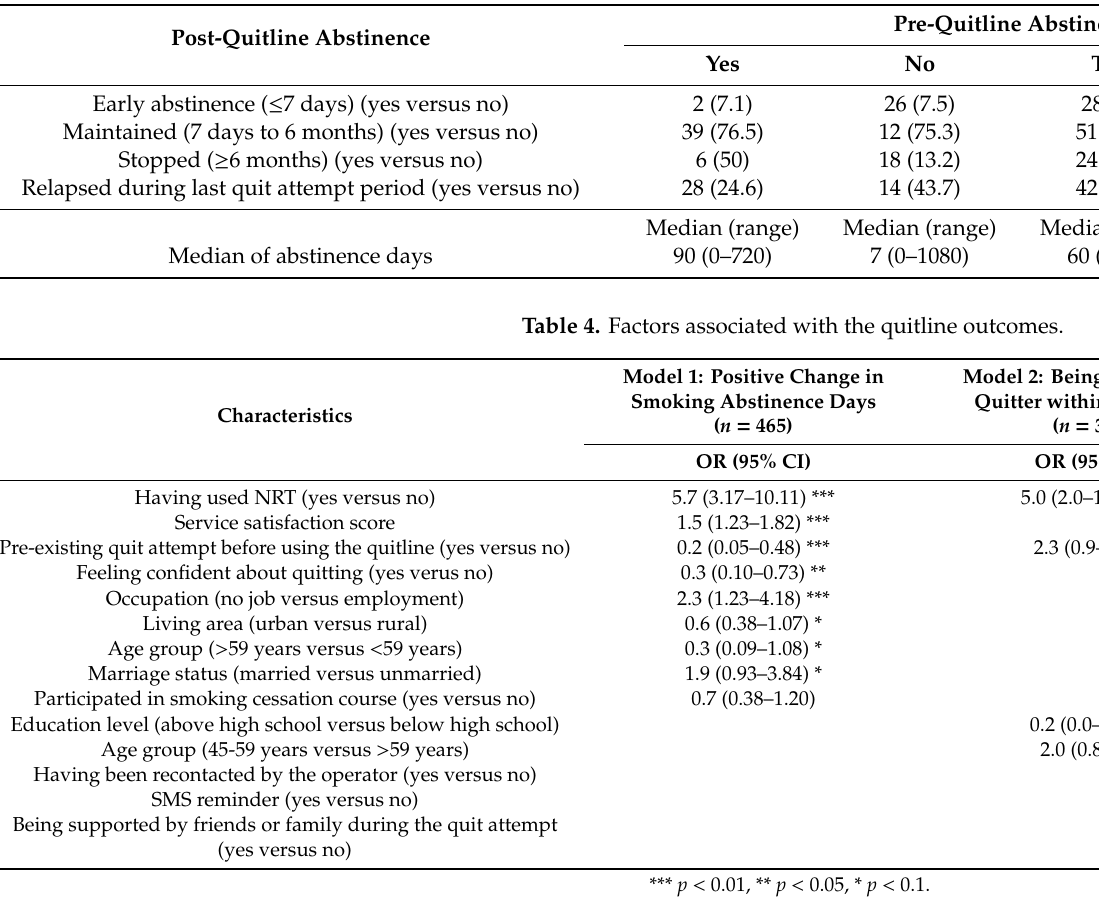
Table 3. Outcome of smoking abstinence pre- and post-quitline use among quitters ( n = 148). Legend: OR, odds ratio.